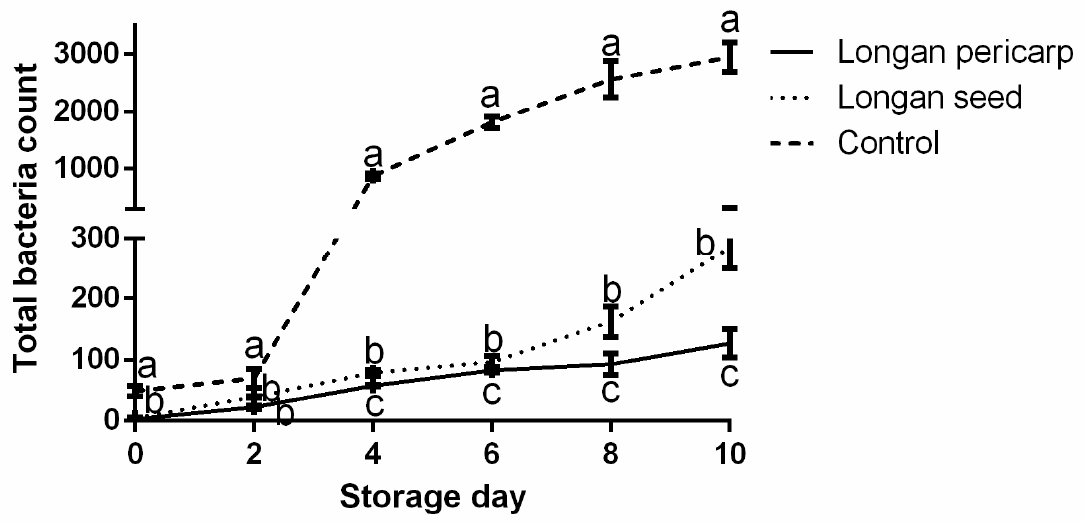
Figure 3. Changes in the total bacteria contents of fresh-cut lotus roots. The units in the x − and y − axes denote the day and cfu g − 1 , respectively. In the results, “a” represents the reference group, b represents significant differences with the “a” group (such as p < 0.05), c represents more significant differences with the “a” group (such as p < 0.01)